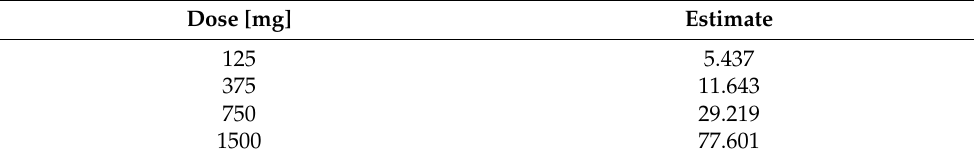
Figure 4. Goodness-of-fit plots of the in vitro release model stratified on the dose level. For each dose level, model predictions are plotted against individual experimental data.